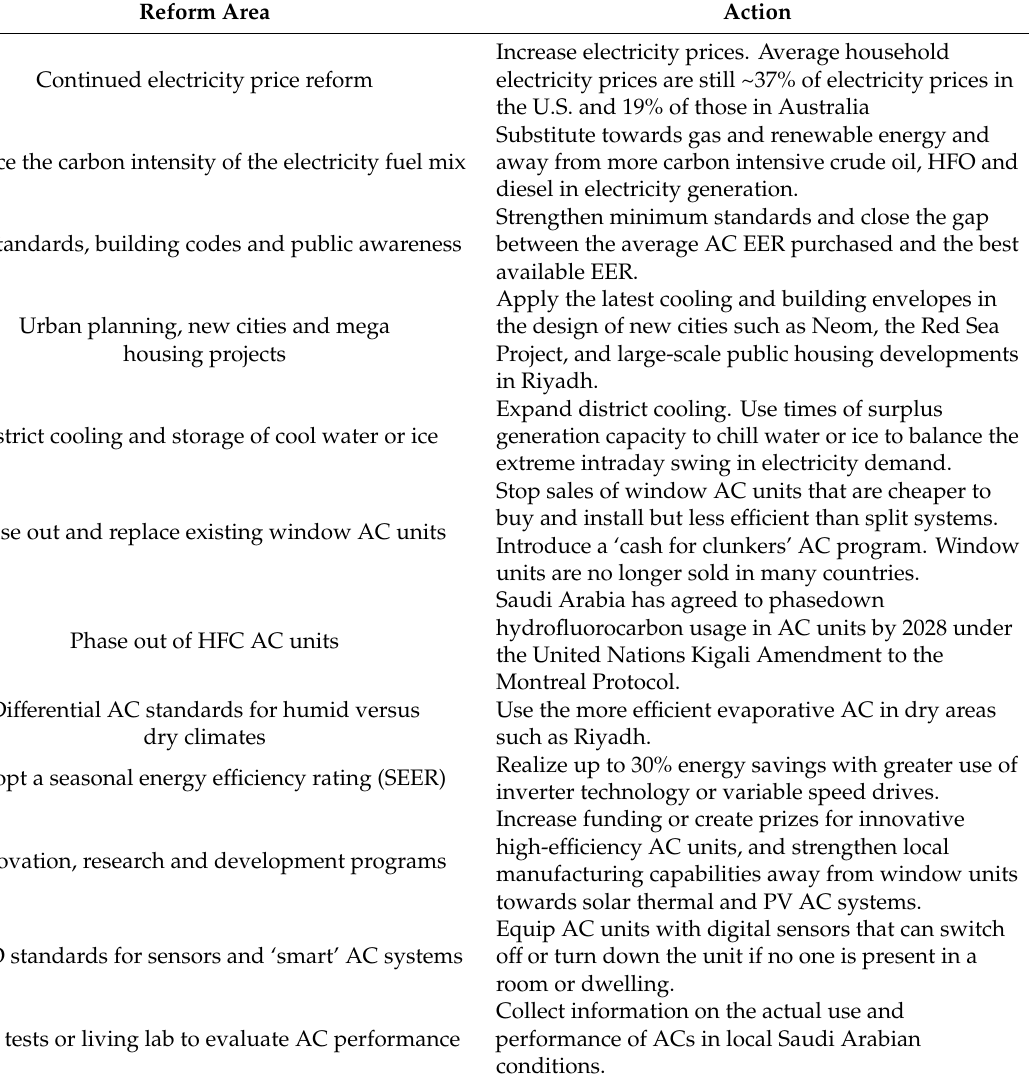
Table 2. Summary of key areas for sustainable cooling in Saudi